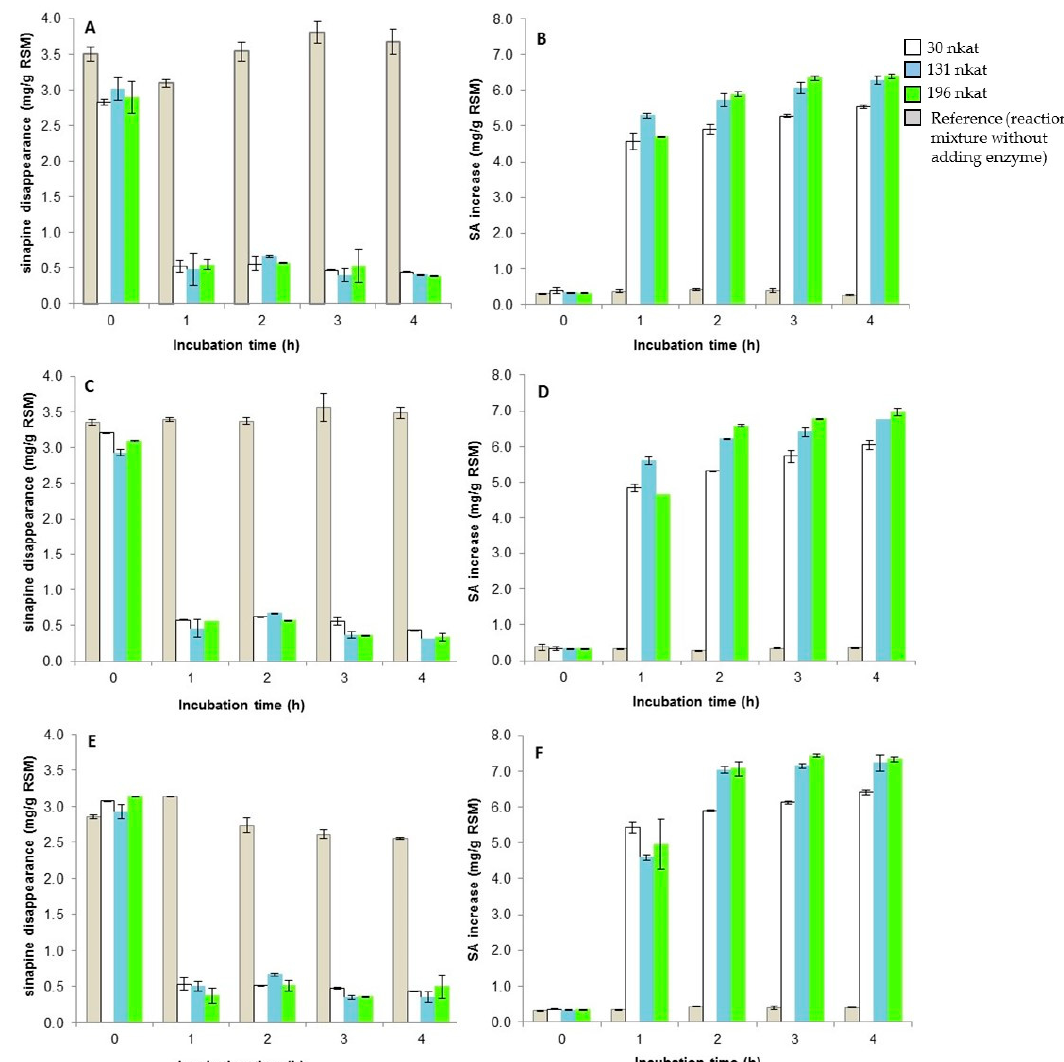
Figure 3. Time course of sinapine disappearance and SA increase in the reaction mixture of hydrolysis as a function of the amount of AnFaeA and temperature. A , B : 37°C, C , D : 45°C, E , F : 55°C.